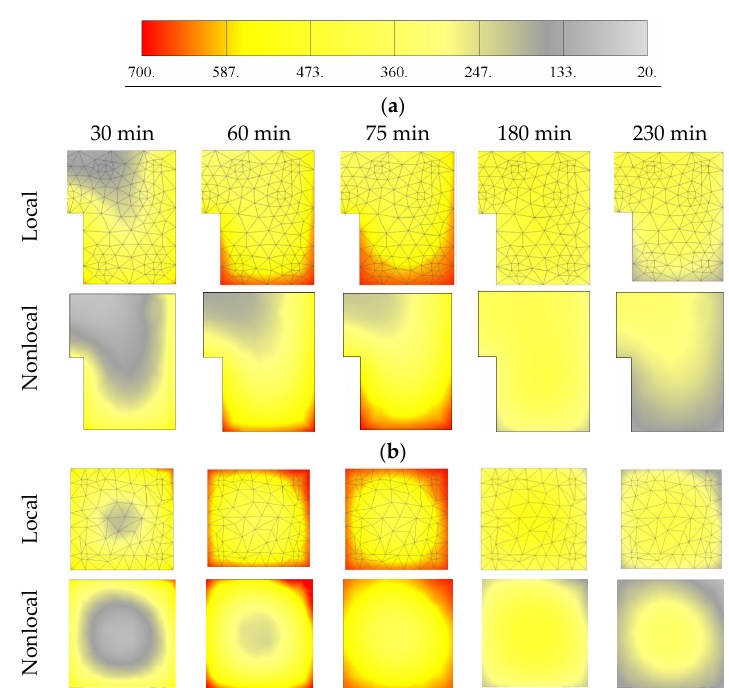
Figure 8. Experimentally measured and numerically obtained distribution of temperatures (local) at different locations: ( a ) column and ( b ) slab.